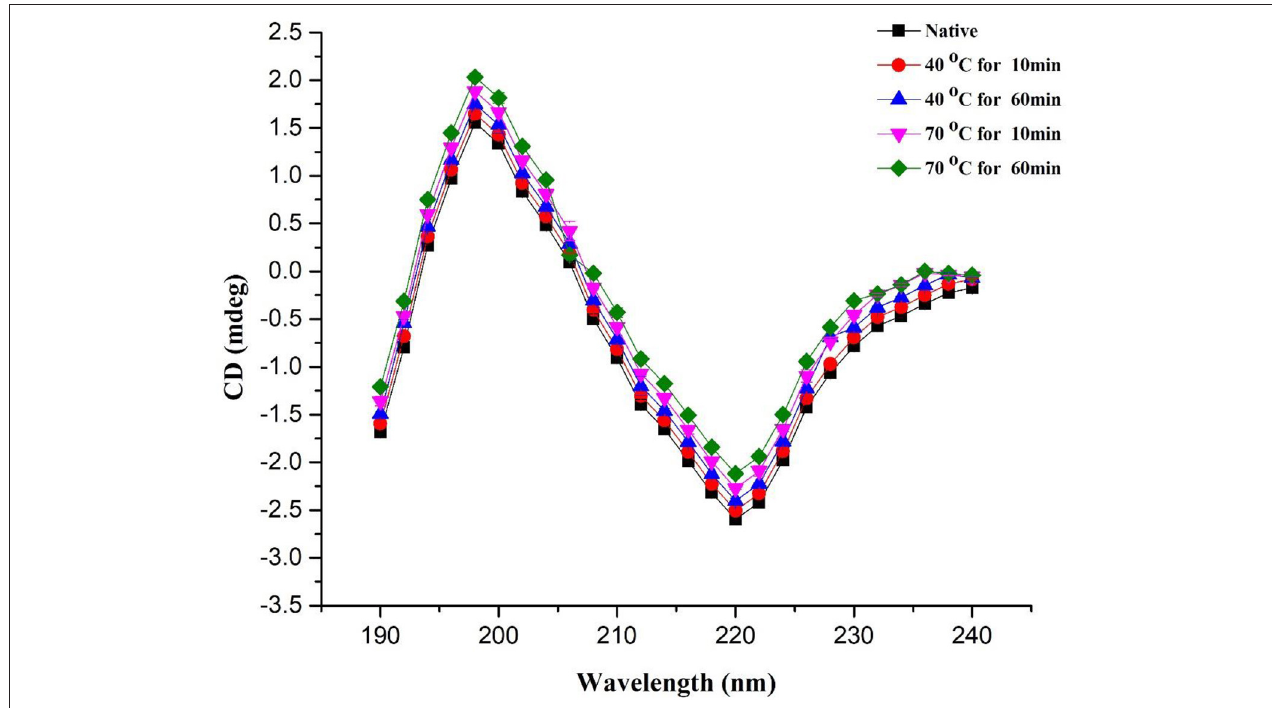
FIGURE 3 | CD spectra of PPO during heating from 40 to 70 ◦ C for a short (10min) and long periods (60min). All data were the means ± SD .